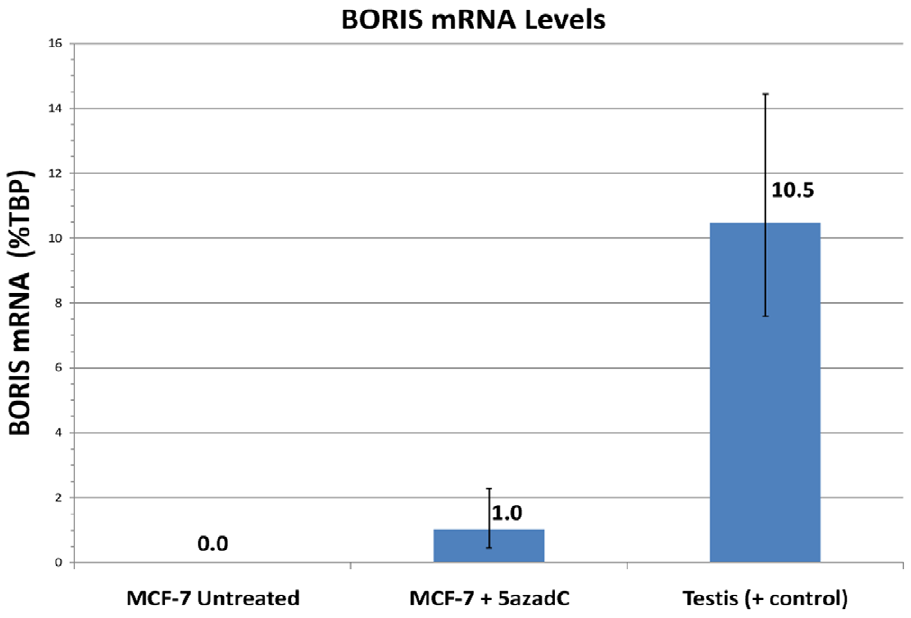
Figure 4. Endogenous BORIS mRNA expression is induced by 5-aza-2 9 -deoxycytidine. BORIS mRNA levels in MCF-7 cells were determined by qRT-PCR (as in Figure 2). Endogenous BORIS mRNA was detectable (1.02% TBP ) only after treatment with the demethylating agent, 5-aza-2 9 - deoxycytidine (5-aza-dC) and at a level approximately one tenth of that in testis (1.02% vs. 10.47% TBP ).